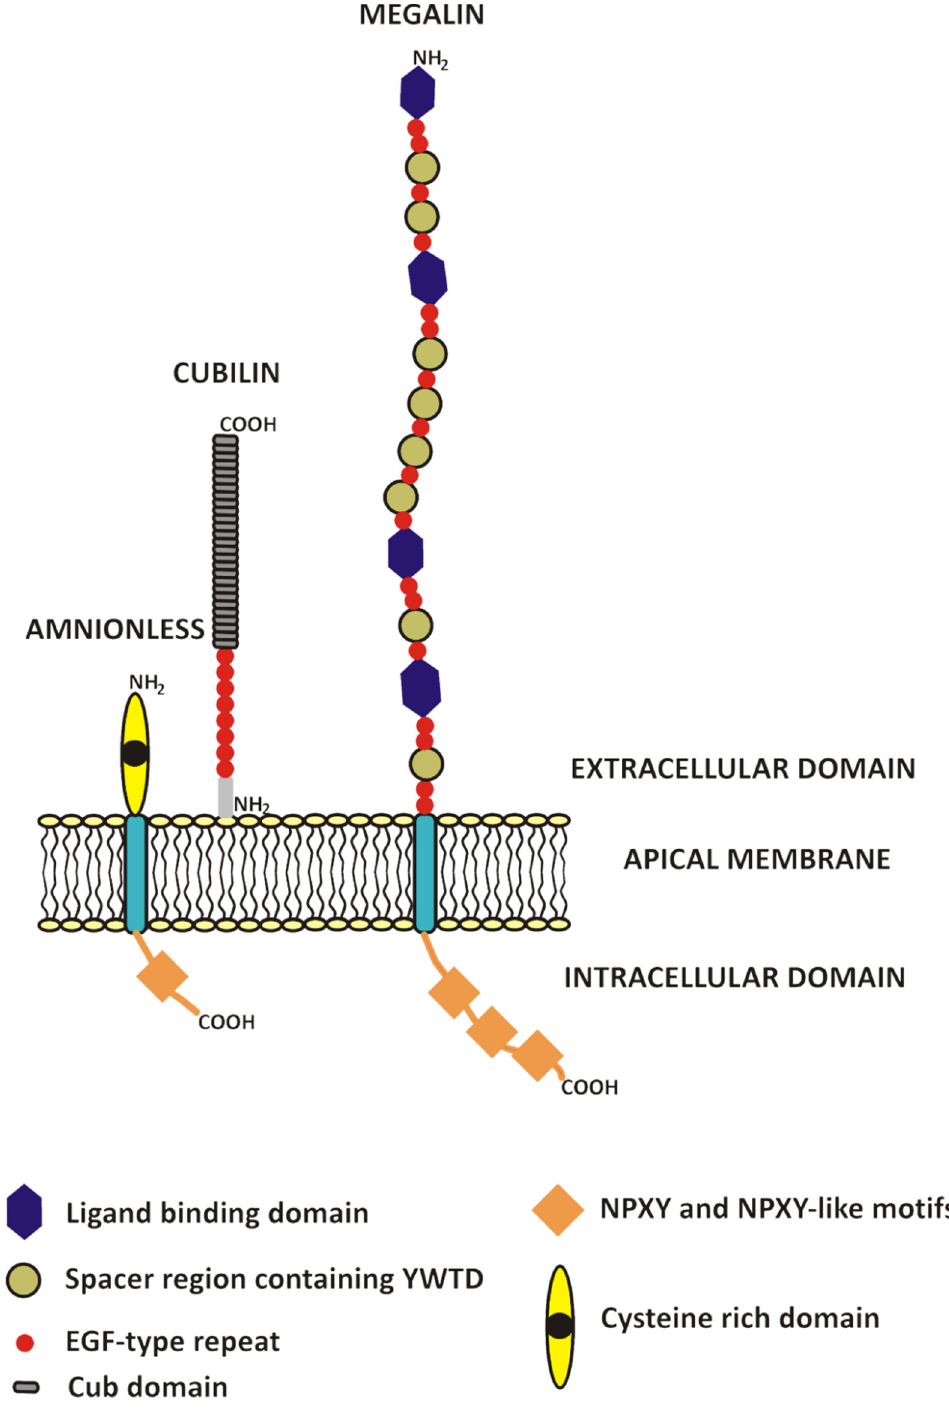
Figure 1. Endocytic megalin-cubilin-amnionless complex in the apical membrane of the renal proximal tubule.